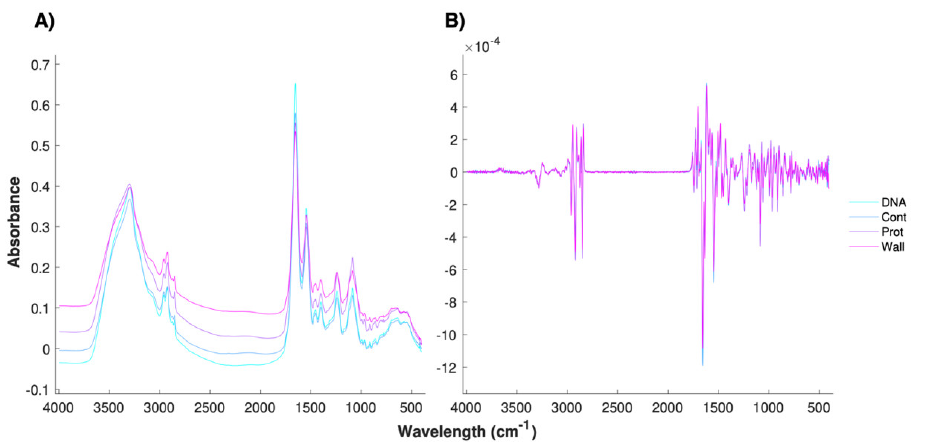
Figure 2. Average spectra of independent cultures exposed to Ciprofloxacin (DNA), Control (Cont), Kanamycin (Prot), and Amoxicillin (Wall) before any manipulation ( A ) and after the application of the optimal preprocessing strategy ( B ). These antibiotics were chosen as representatives of the major affected biosynthetic pathways.